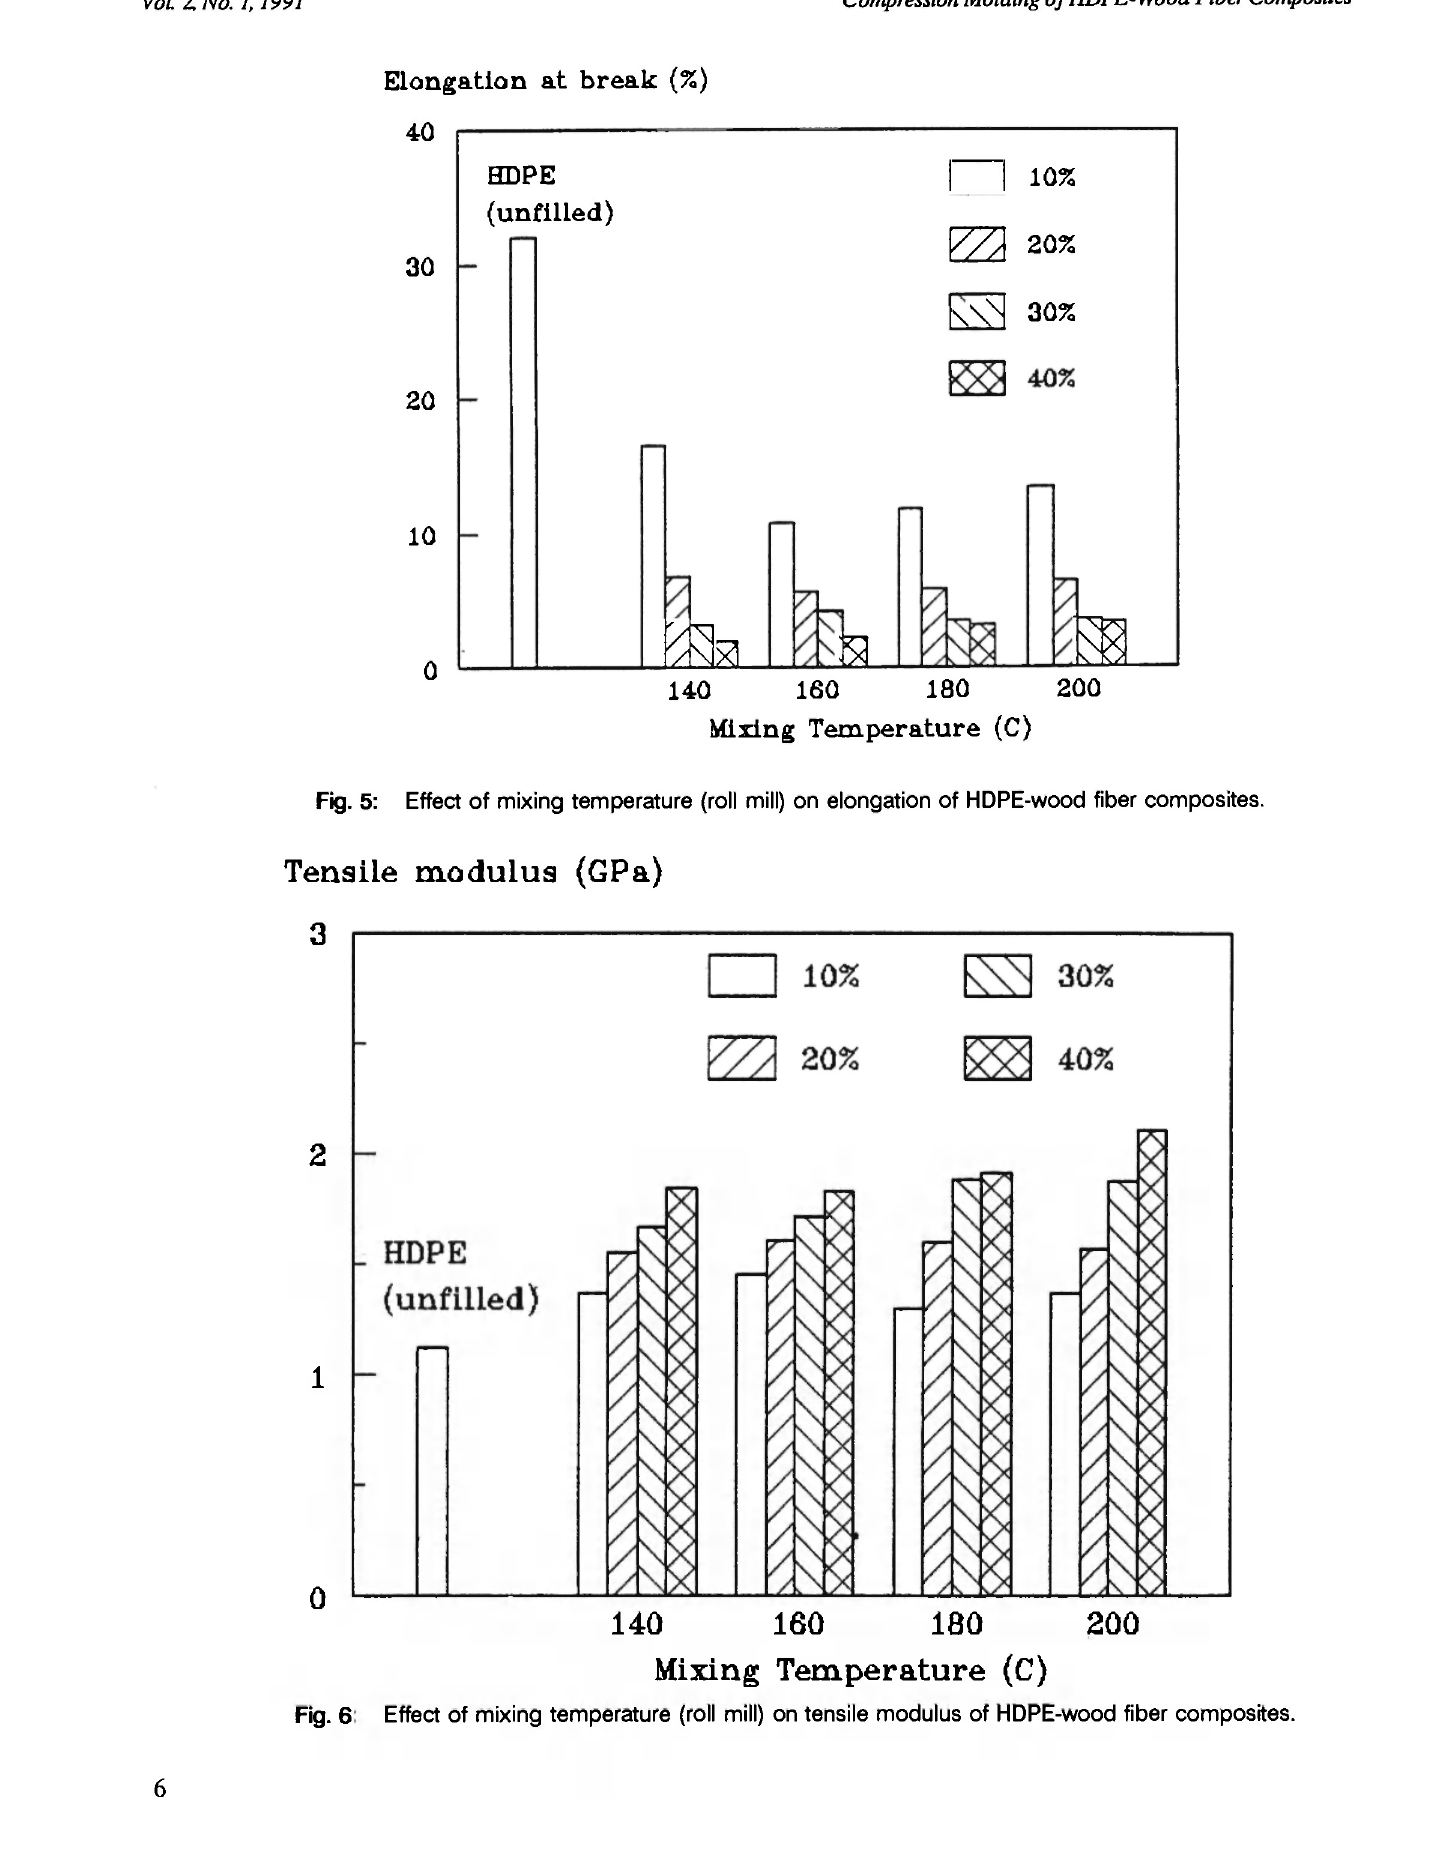
Effect of mixing temperature (roll mill) on tensile modulus of HDPE-wood fiber